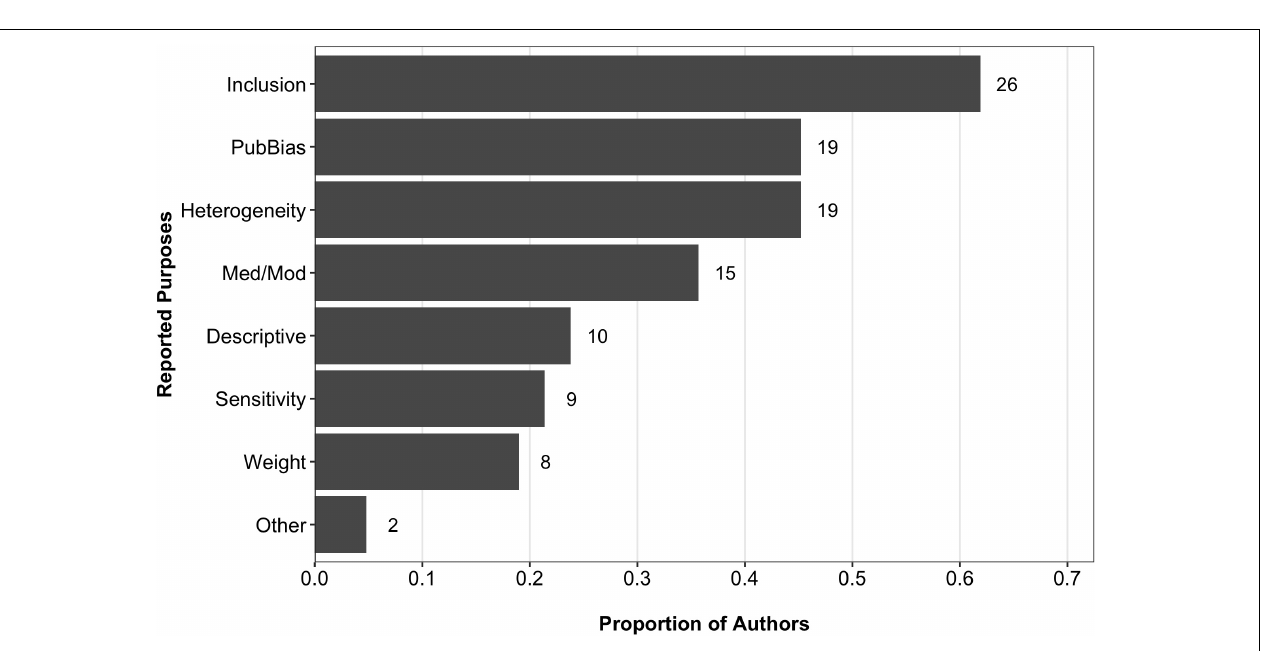
FIGURE 2 | Proportions and frequencies of reported purposes for assessing PSQ. Data source: QUASR-R coding. Descriptive, descriptive assessment only; Inclusion, inclusion criteria; Pred/Mod, use of quality as a predictor or moderator; PubBias, publication bias; Sen/Sub, sensitivity/subgroup analysis. N = 117.